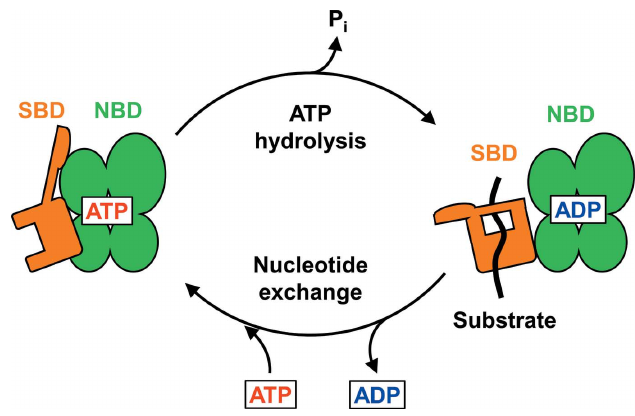
Figure 1 Schematic view of the allosteric regulation of the substrate binding of